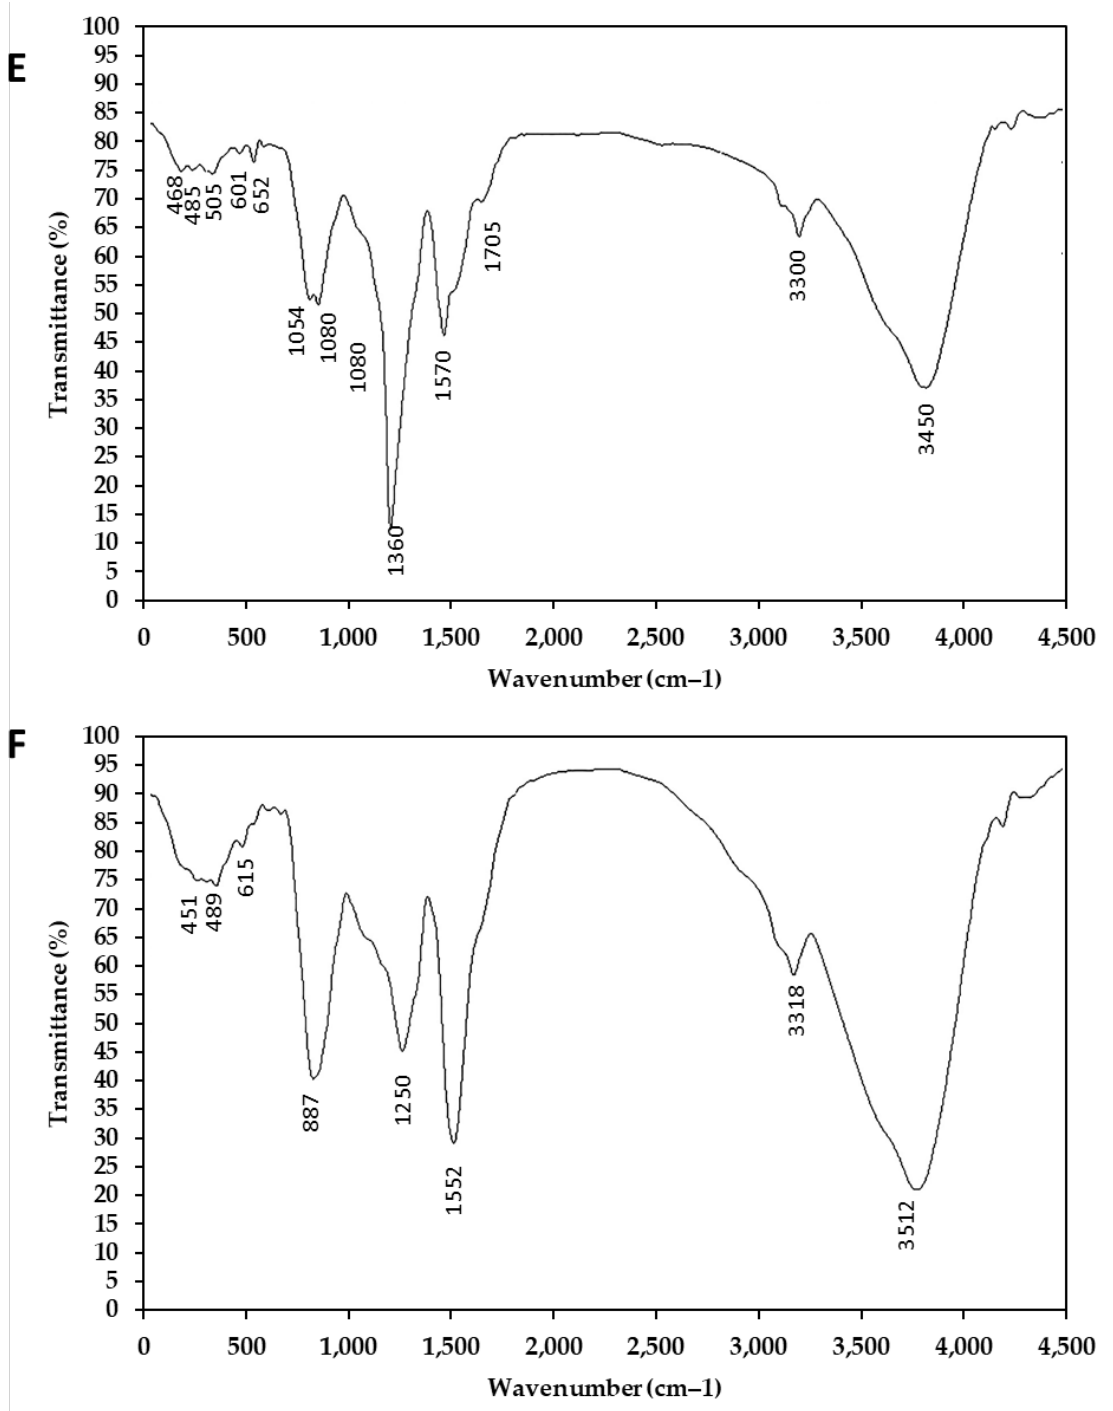
Figure 1. Characterization of the green AgNPs fabricated by olive leaf waste extract (OLWE). ( A ) UV absorbance at 400 nm; ( B ) the average size of spherical nanoparticles from 20 to 45 nm; ( C ) surface charge of − 21 eV; ( D ) size of 32 nm; ( E ) active groups in AgNPs; ( F ) active groups in OLWE.